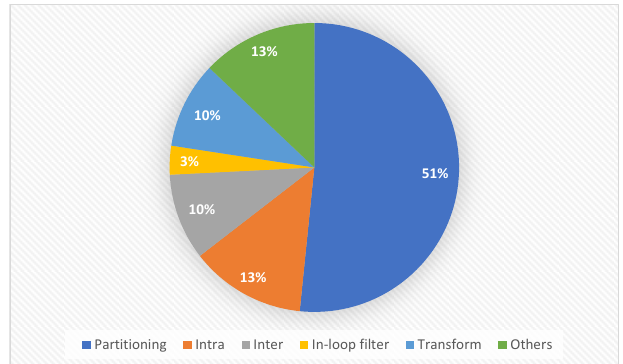
Figure 3. Classification of research into fast VVC.